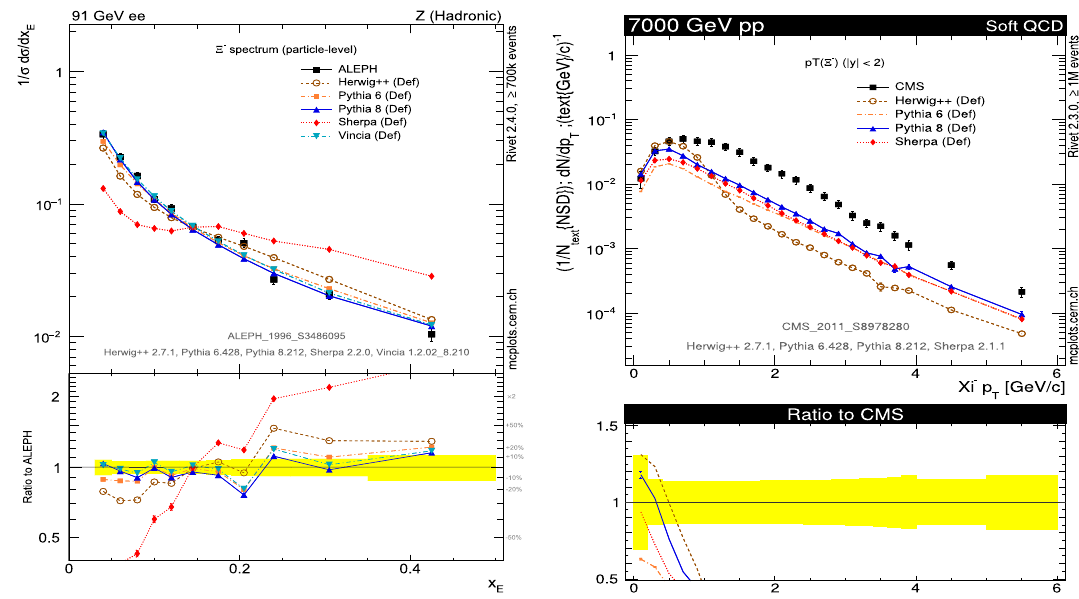
Fig. 5.3 (cid:23) − spectra measured by the ALEPH experiment at LEP I (left) and by the CMS experiment at the LHC compared to the predictions from modern event generators